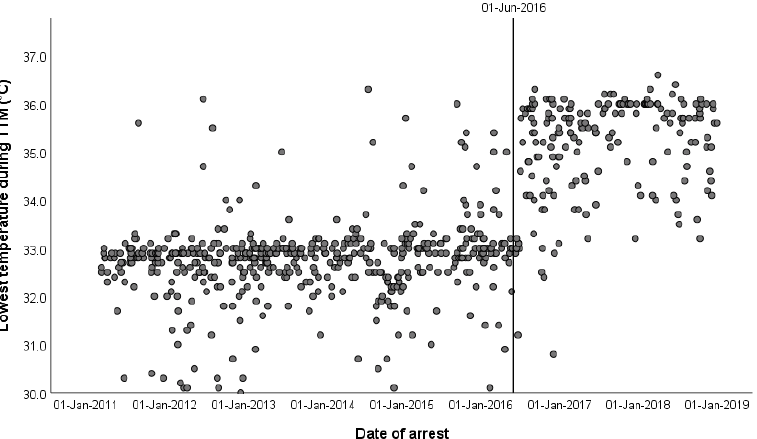
Figure 1. Scatterplot of the lowest temperatures during TTM (vertical line represents the adaption of the TTM protocol). 24/497 (4.8%) of the patients in the TTM33 group had a lowest temperature of 34 °C or higher.